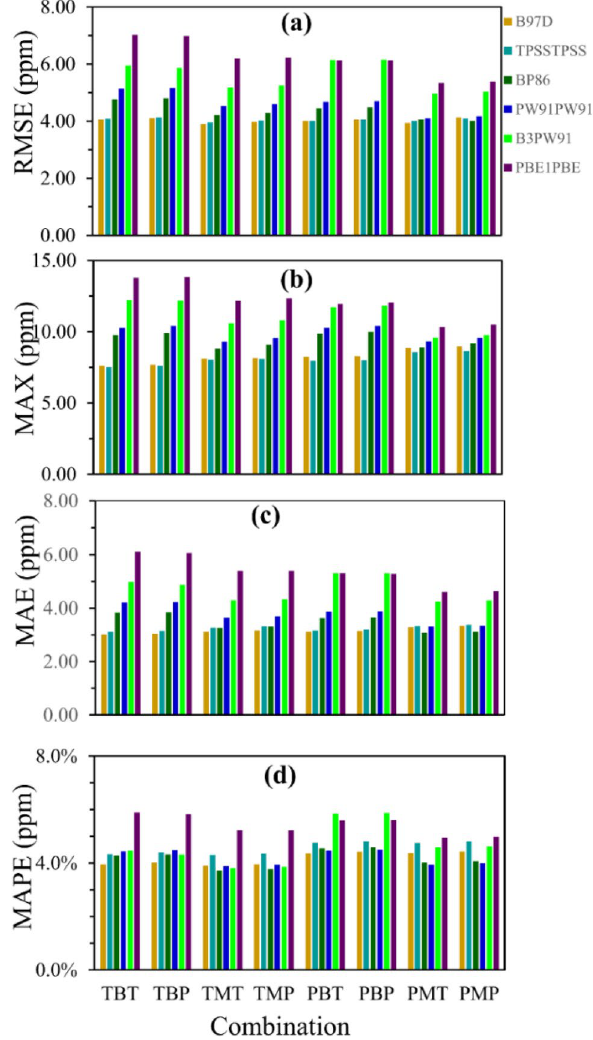
Figure 7. Graphical representation of statistical descriptors (( a ) RMSE, ( b ) MAX, ( c ) MAE and ( d ) MAPE) computed for 13 C deviations versus each combination of geometry and basis set. Notice: T and P denote TZVP basis sets, B and M correspond to B3LYP and M06-2X DFT functionals used for the geometry optimization